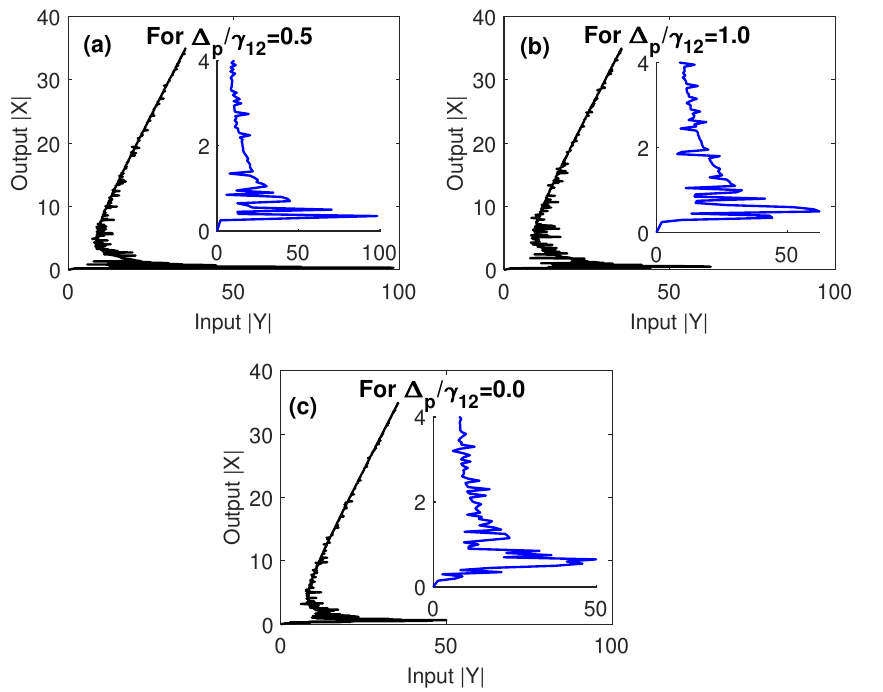
∆ p , under EIT conditions; γ 12 = 0.4 rad, θ = 1 rad and C = 121.36, M G